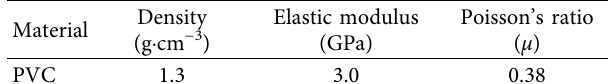
Table 2: Mechanical parameter of the shaped charge cover [23].